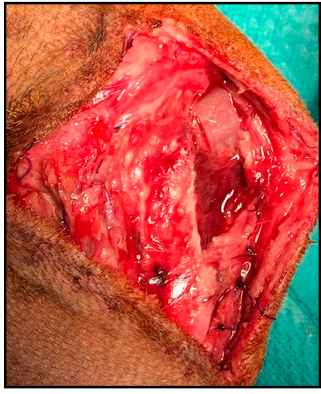
Figure 4. Implant rupture.